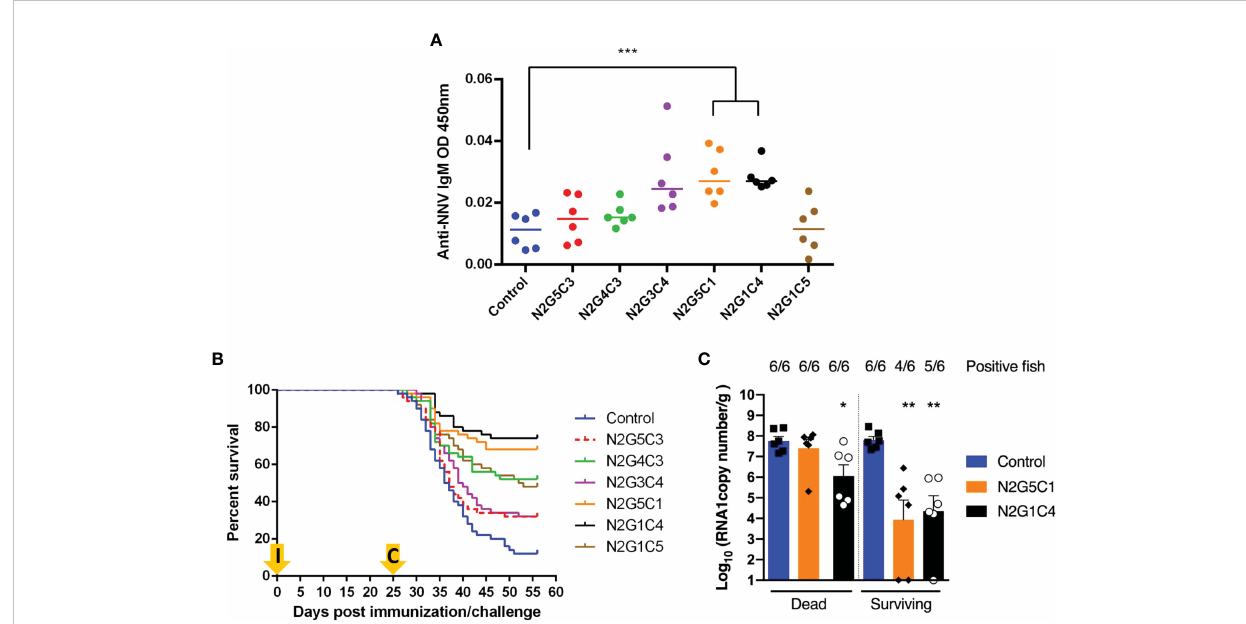
FIGURE 9 Fish survival curves following immunization by injection of sole with rVHSV GO -NNV and challenge with NNV by bath immersion. Fifty virus-free juvenile sole (mean weight of 4 g) were injected with 6 rVHSV GO -NNV as described in materials and methods. (A) Twenty-one days post infection, six fi sh per group were sacri fi ced and blood samples were taken. The levels of anti-NNV antibodies in sera from immunized sole was evaluated by ELISA. (B) Fish mortality rates were recorded every day for 25 days. Then, rVHSV GO -NNV-immunized fi sh were challenged with NNV by bath immersion. Fish mortality rates were recorded every day for 31 additional days. (C) NNV replication in brain tissues of immunized fi sh. Six dead fi sh and six surviving fi sh randomly harvested at day 30 post-challenge in the indicated groups were analyzed by RT-qPCR. Virus loads are expressed as RNA1 copy per gram of brain. Number of positive fi sh are indicated above each histogram. For statistical analysis, a comparison between groups was performed with a one-way ANOVA and Tukey ’ s multiple comparison tests using GraphPad Prism (GraphPad, San Diego, CA). Groups that are signi fi cantly different are denoted *( p < 0.05), **( p < 0.01), ***(p <